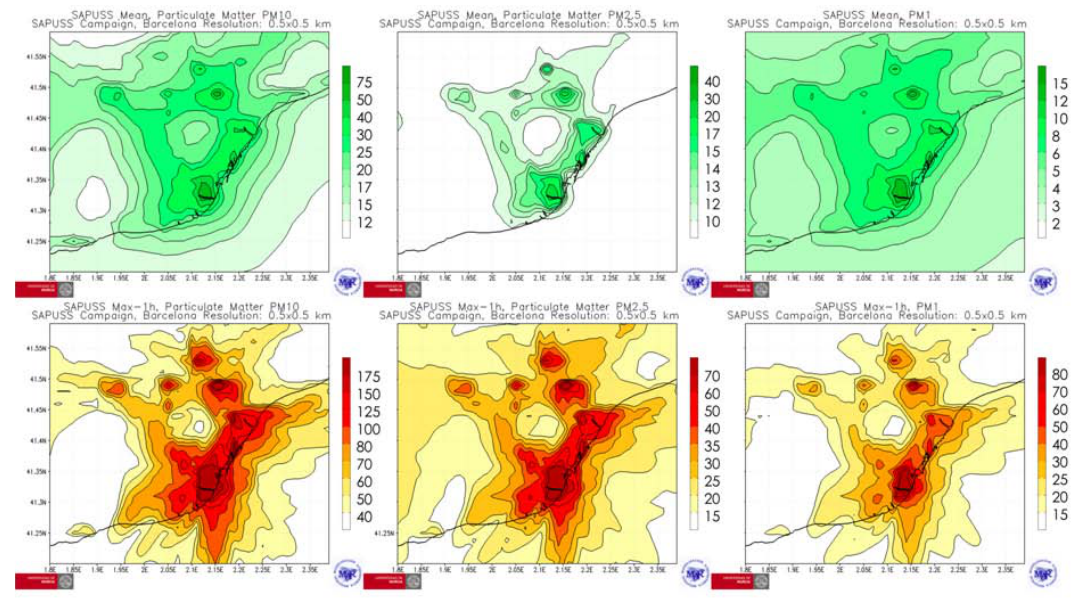
Fig. 12. Mean (top row) and 1h maximum (bottom row) ground-level concentrations of (from left to right) PM 10 , PM 2 . 5 and PM 1 modelled during the SAPUSS field campaign in the Barcelona Metropolitan Area. Levels are expressed in µgm − 3